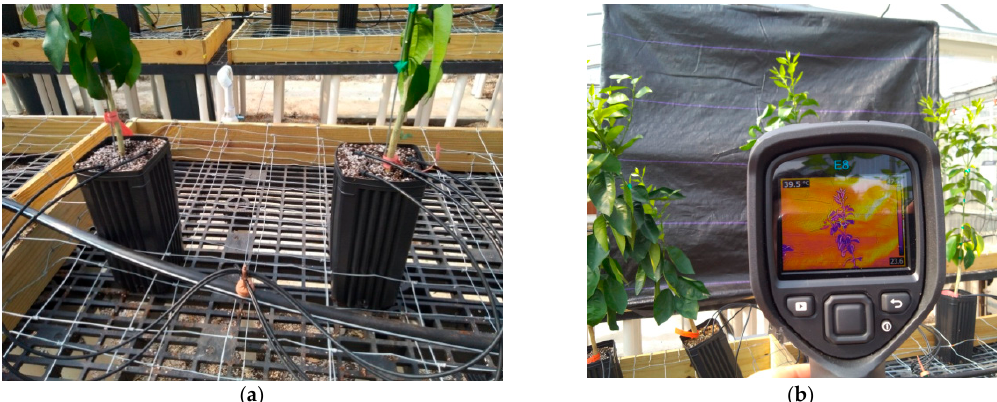
Figure 3. ( a ) Irrigation lateral line and distribution of drip stakes for treatment application in the pots placed on the benches with wireframes; ( b ) image capturing in one-year-old citrus plants, with the thermal camera, using a black screen as a background.